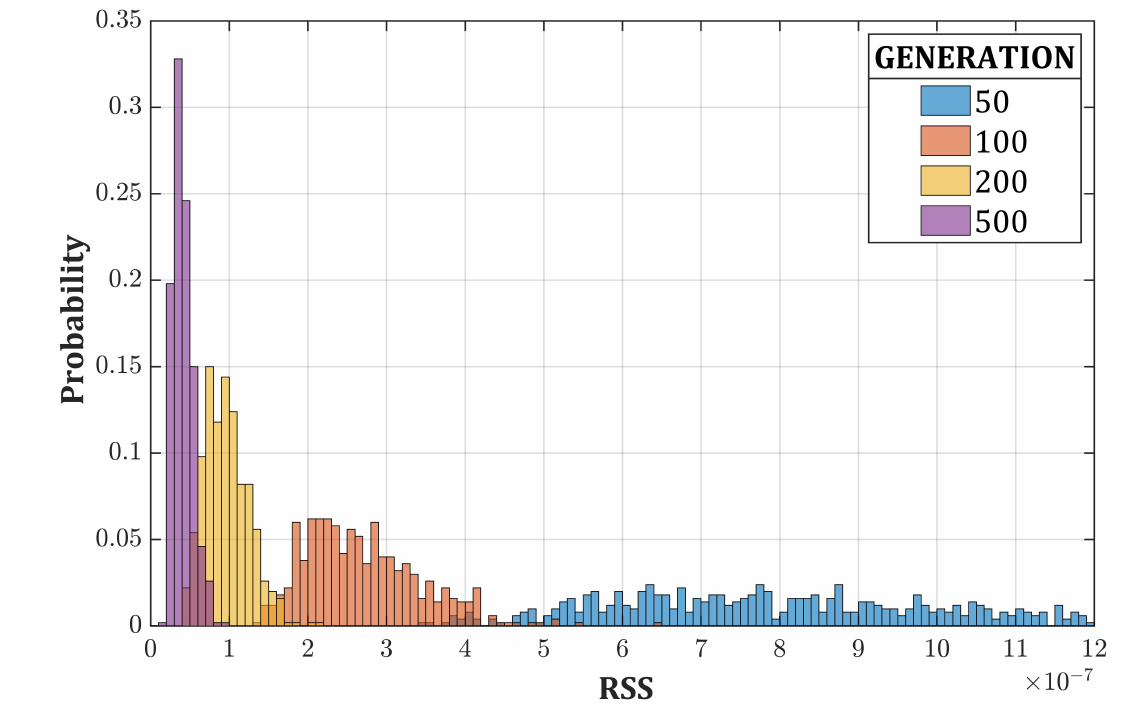
Figure 9. Probability density function of the RSS for the 137 Cs spectrum as a function of the number of iterations for the standard GA (500 run